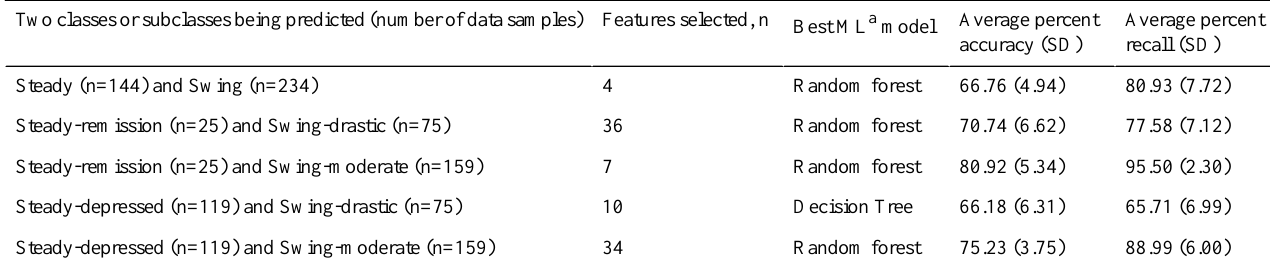
Table 3. Classification result using selected features of phone